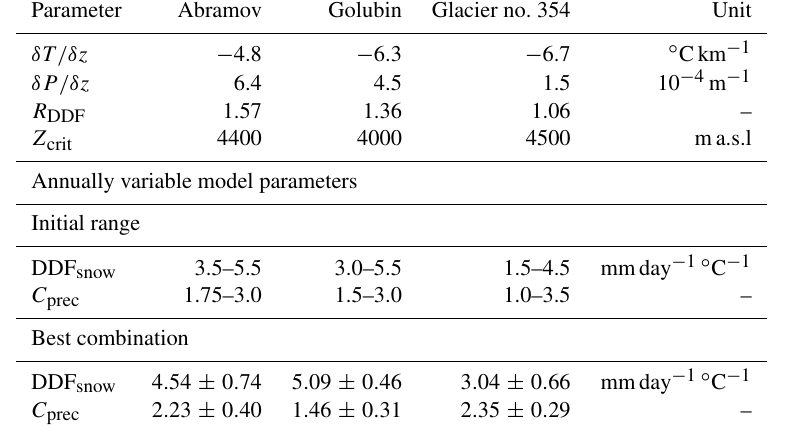
Table 3. Constant model parameters. The temperature lapse rate for Abramov was adopted from Barandun et al. (2015) and for Golubin and Glacier no. 354 from Aizen et al. (1995). δT/δz , δP/δz , Z crit and R DDF are held constant throughout the entire modelling period. The initial parameter ranges of DDF snow and C prec , as well as the mean value obtained from annual calibration, is given with its standard deviation. Parameter Abramov Golubin Glacier no. 354